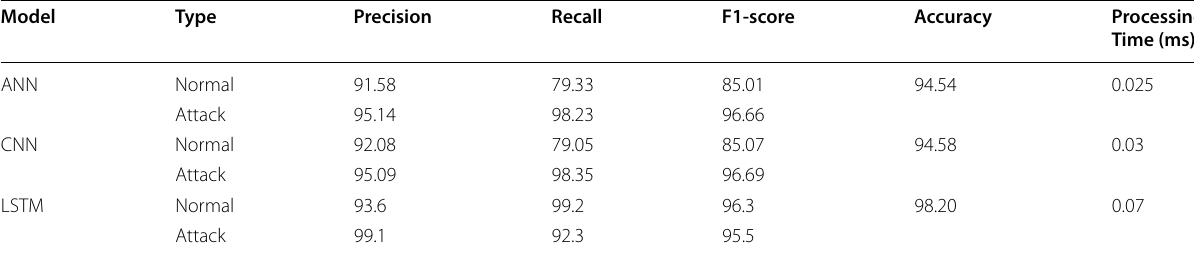
Table 5 Model results for binary classification